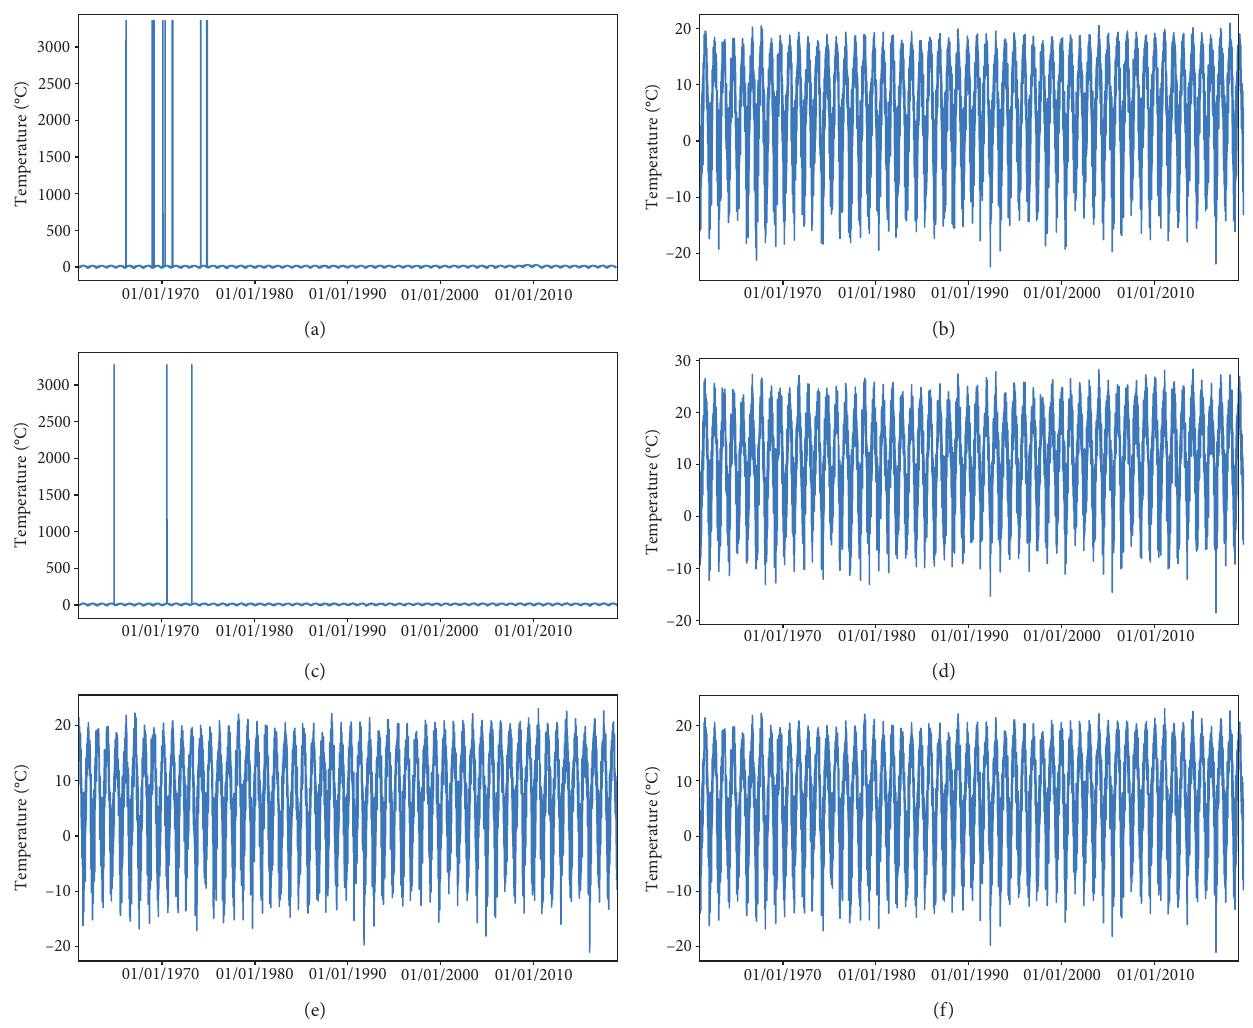
Figure 1: Comparison of original data and revised data of national conventional station dataset from 1961 to 2018. (a) Original minimum temperature in the last 24 hours. (b) Minimum temperature in the last 24 hours by quality control. (c) Original maximum temperature in the last 24 hours. (d) Maximum temperature in the last 24 hours by quality control. (e) Original average temperature in the last 24 hours. (f) Average temperature in the last 24 hours by quality